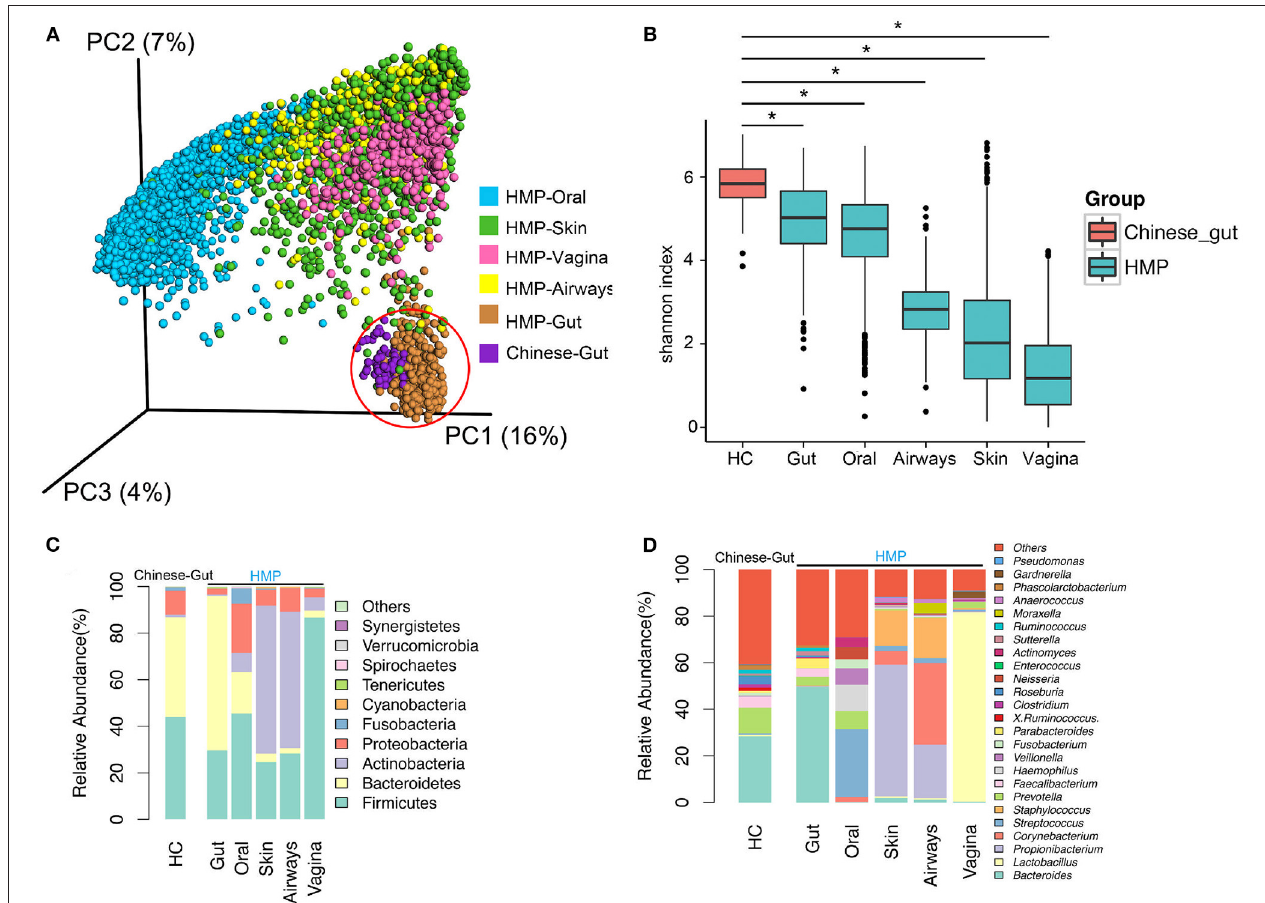
FIGURE 1 | Diversity and abundance of bacteria from the gut and other anatomical locations (oral, skin, airway, and vagina) obtained from healthy subjects in China and Human Microbiome Project (HMP) data. (A) Bacterial β -diversity, illustrated by principal coordinate (PC) plots of unweighted UniFrac distance. PC1, PC2, and PC3 captured most of the similarities in microbiota, as shown by percentages. (B) Bacterial α -diversity according to the Shannon diversity index. Bacterial diversity differed significantly between a healthy population from China and HMP samples. (C) Microbial composition at the phylum level. (D) Microbial structure at the genus level. HC, healthy controls. *, p <